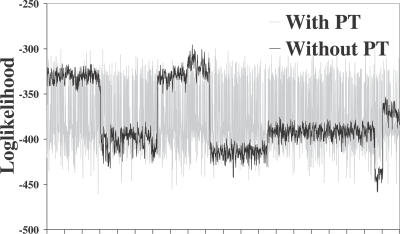
Loglikelihood as a Function of the Steps in the MCMC Chain for the HDV set with and without Parallel TemperingWith parallel tempering (grey) and without parallel tempering (black). Without parallel tempering, the MCMC chain gets stuck in local minima.